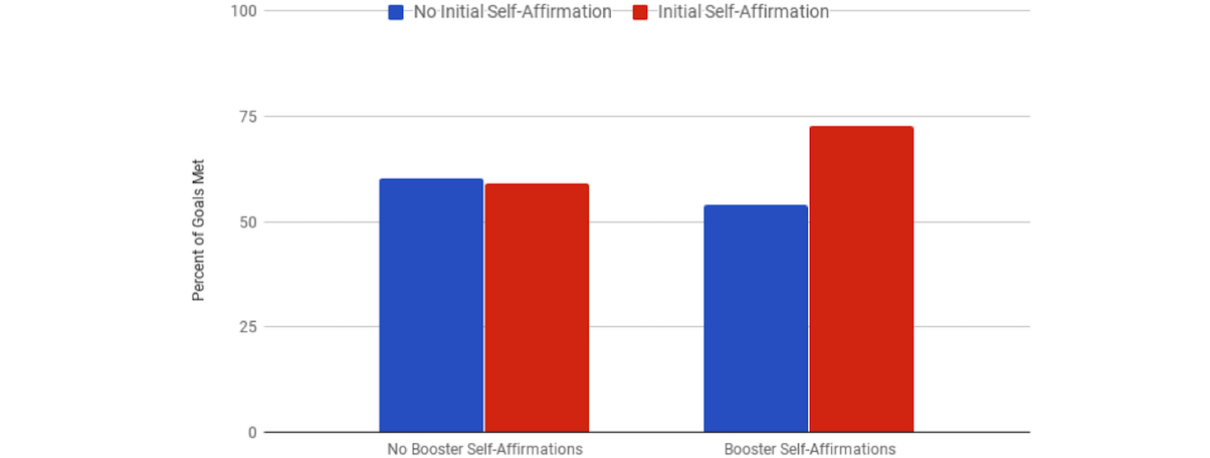
Figure 3. Percentage of goals met by